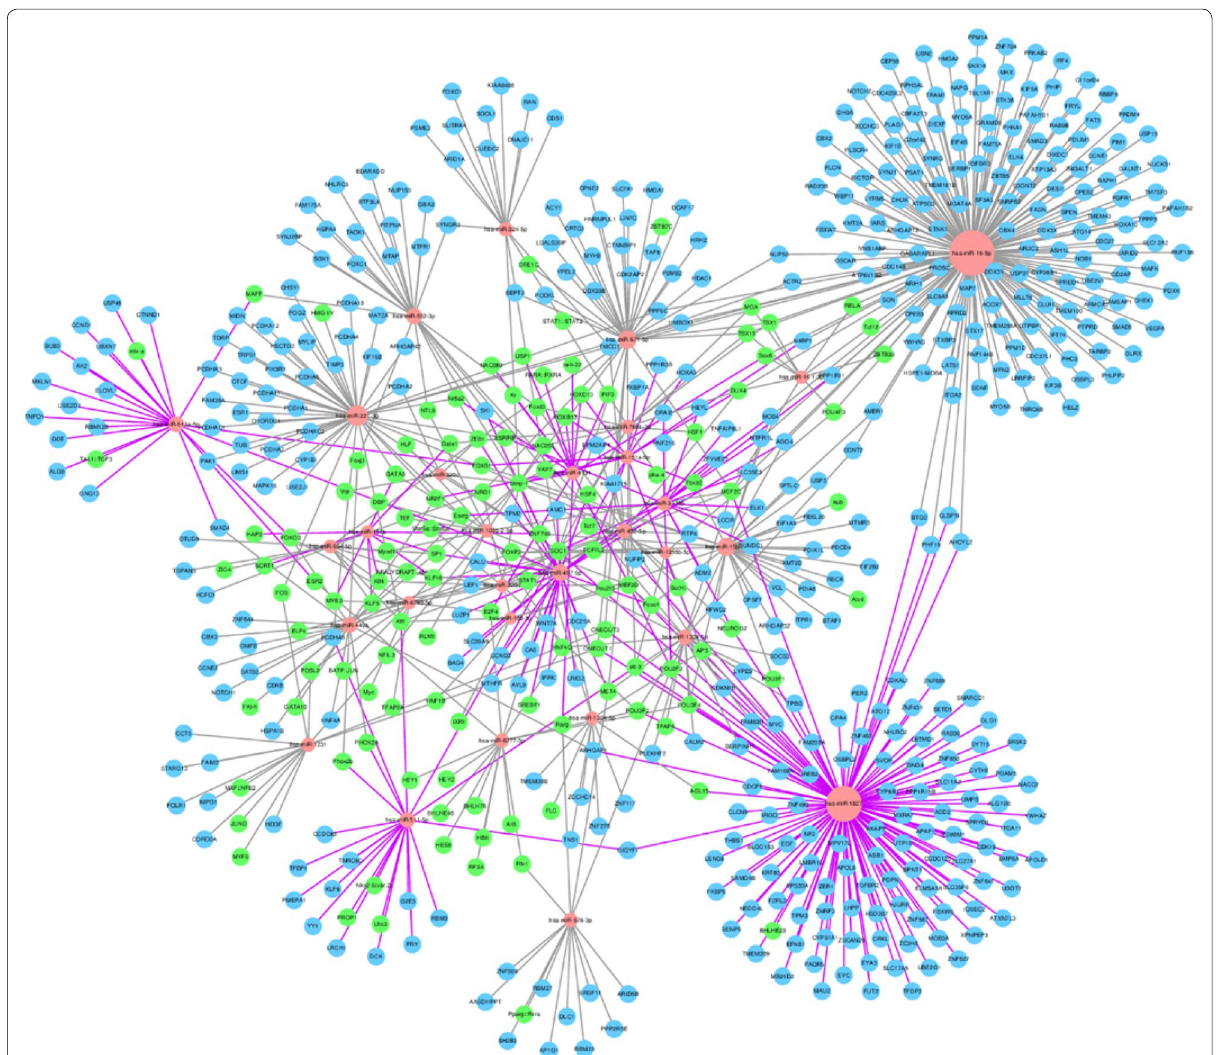
Fig. 7 Network interactions between miRNAs, TFs, and target genes. The red circular nodes are miRNAs, the blue circular nodes are miRNA gene targets, and the green nodes are TFs. The grey line connects with down-regulated miRNAs, and the purple line connects with up-regulated